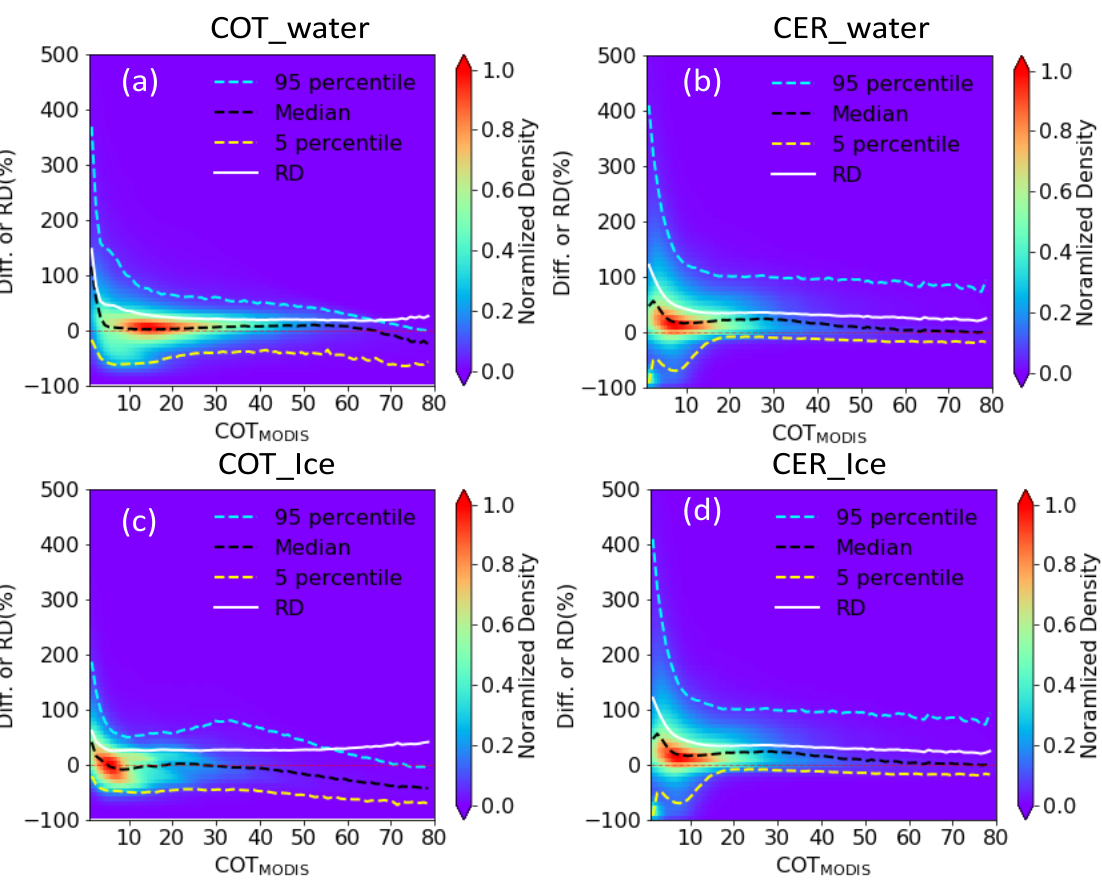
Figure 5. Statistical analyses (95 percentile, mean, 5 percentile, and RD values) of differences in ( a ) COT and ( b ) CER for water clouds and ( c ) COT and ( d ) CER for ice clouds between SGLI and MODIS for different values of MODIS COTs. For detail, see text.